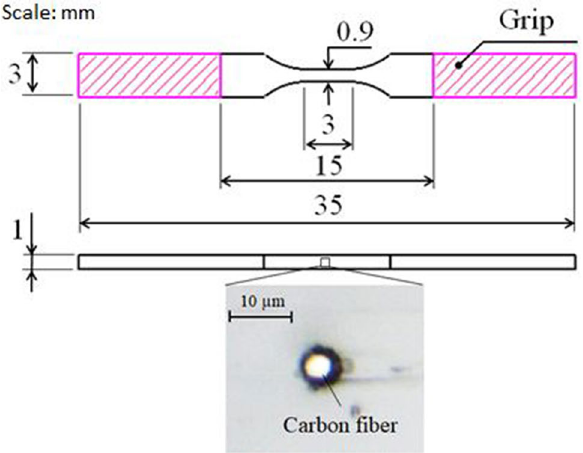
Figure 2. Dimensions of a dumbbell-shaped epoxy sample with a single carbon fiber embedded in the transverse direction. An image of a single carbon fiber observed under a high-magnification digital microscope.